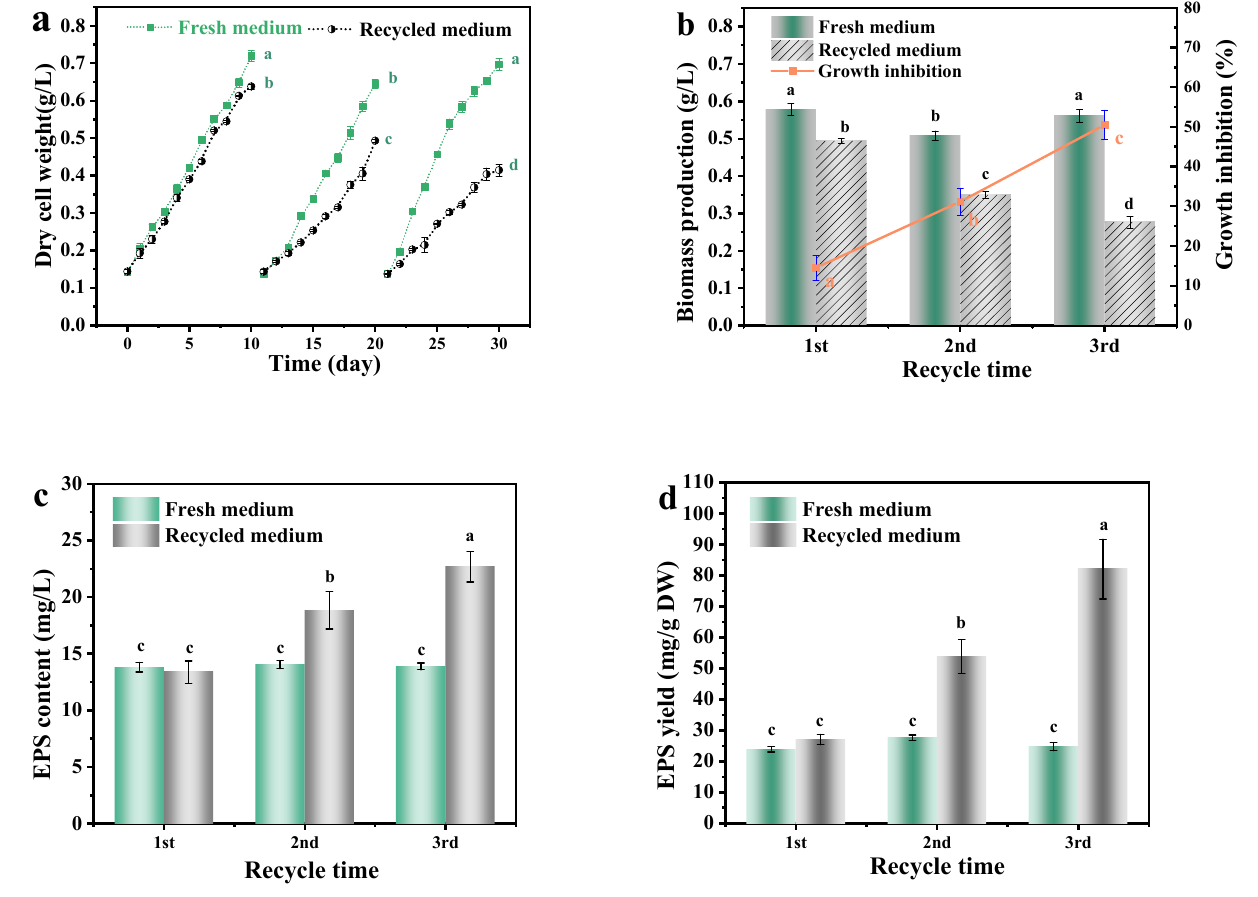
Figure 2. The effects of medium recycling on the growth and EPS secretion of A. platensis : ( a ) Growth curves; ( b ) Biomass production and growth inhibition; ( c ) EPS content; ( d ) EPS yield; DW: dry weight; a–d: Different letters above the bars indicated a significant difference among the groups. Points showed average of three independent measurements; vertical bars indicated the standard deviation. ( p < 0.01, n = 3).